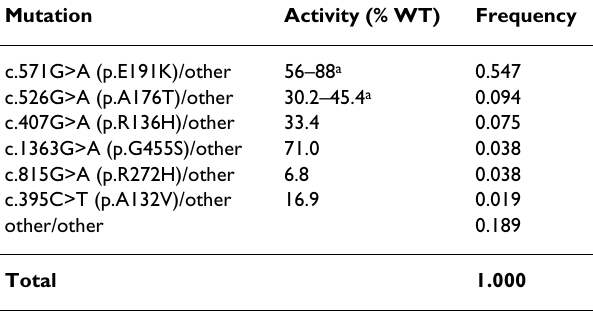
Table 2: The recurrent ALPL gene mutations found in the 53 patients affected with mild HPP and carrying two mutated